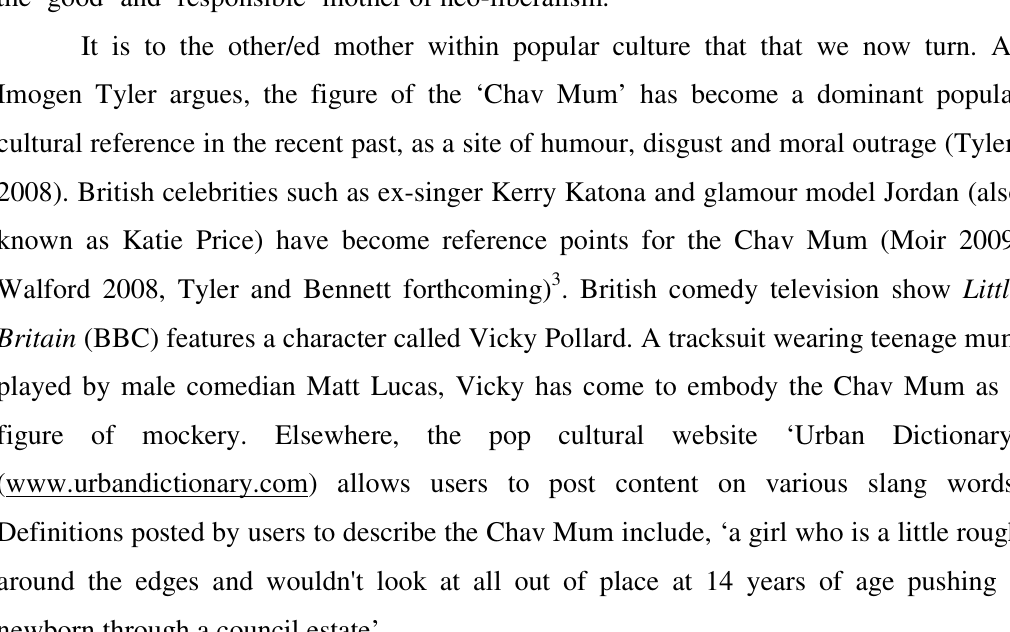
of mockery. Elsewhere, the pop cultural website ‘Urban